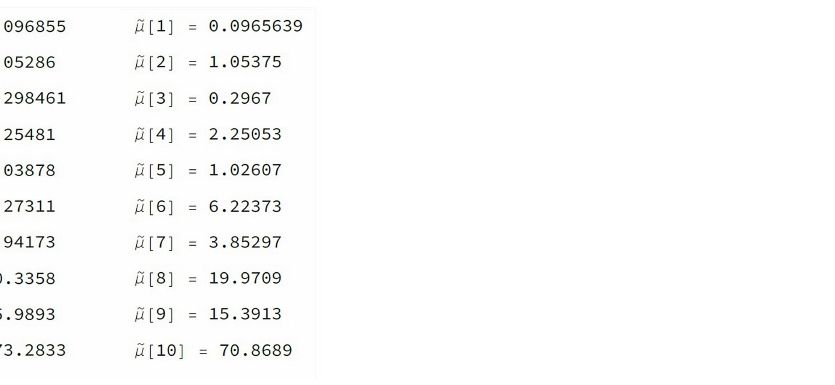
Figure 9. Moments of ψ ( t ) in (29) as computed using the G-KQR ( left ) and the proposed Bell’s polynomial approximation ( right ) methods.